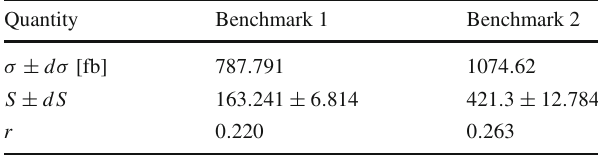
Table 4 Results obtained with CheckMATE 2 based on the atlas_conf_2017_060